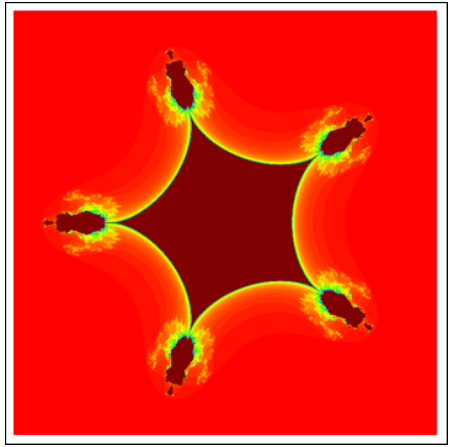
Figure 49. Multi-corn via F-iteration with image visual time = 74.23